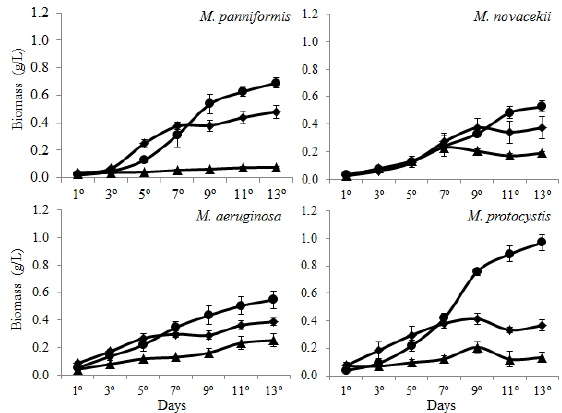
Figure 2 - Growth curves and standard deviations for cyanobacteria species in distinct culture media for 13 days: (•) ASM-1, (♦) BG-11 and (▲) BBM.